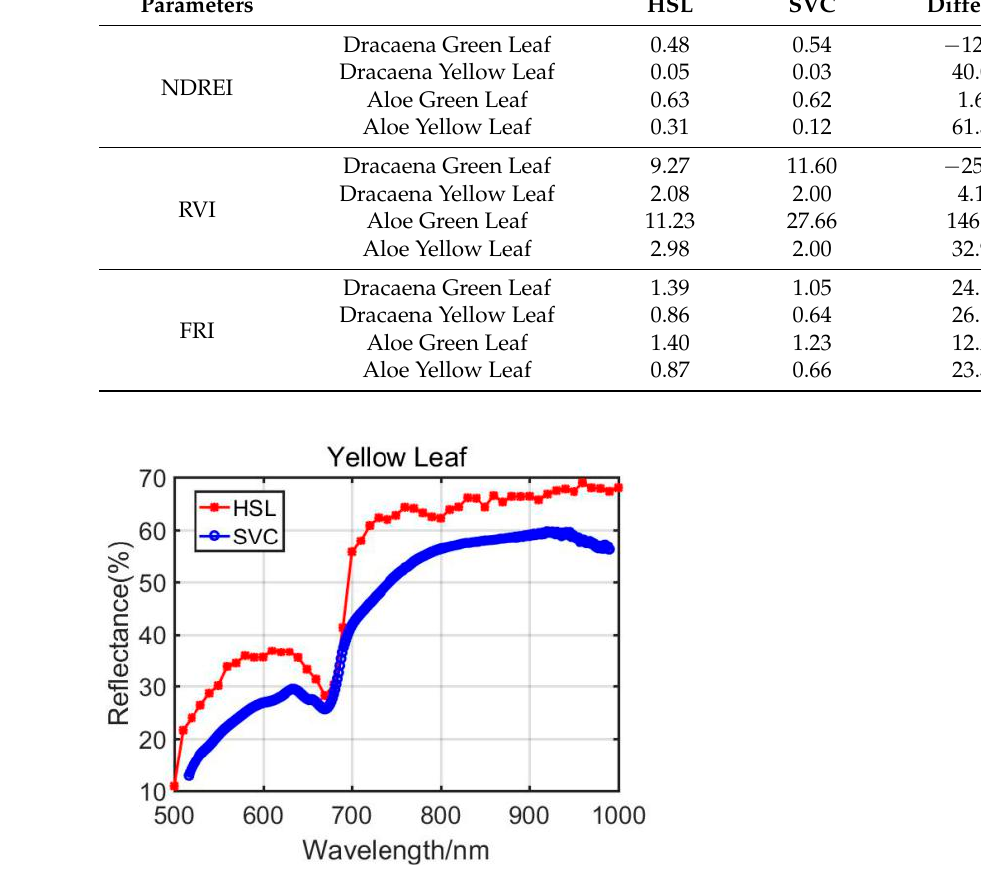
Figure 8. Dracaena yellow leaf spectral profiles.